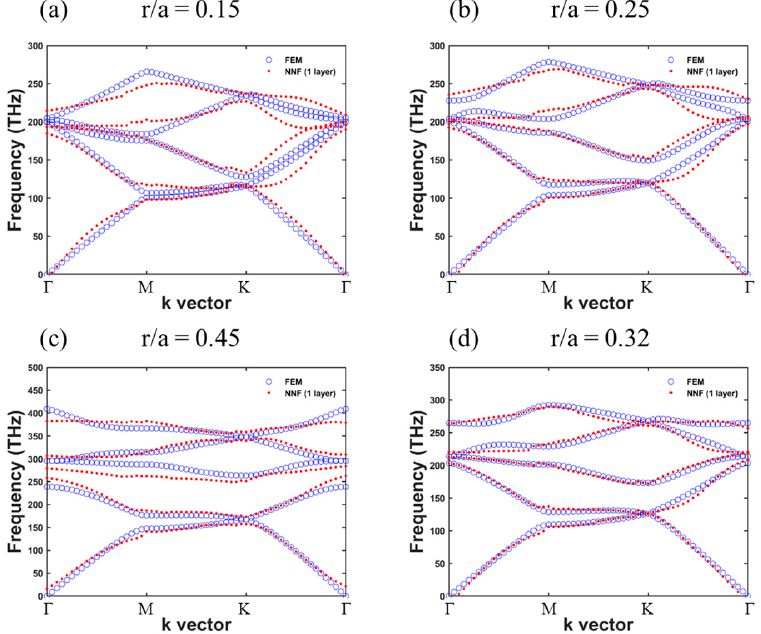
Figure 3. FEM-calculated (blue circles) and predicted (red dots) band structures of triangular lattice photonic crystals with r/a = ( a ) 0.15, ( b ) 0.25, ( c ) 0.45, and ( d ) 0.32.